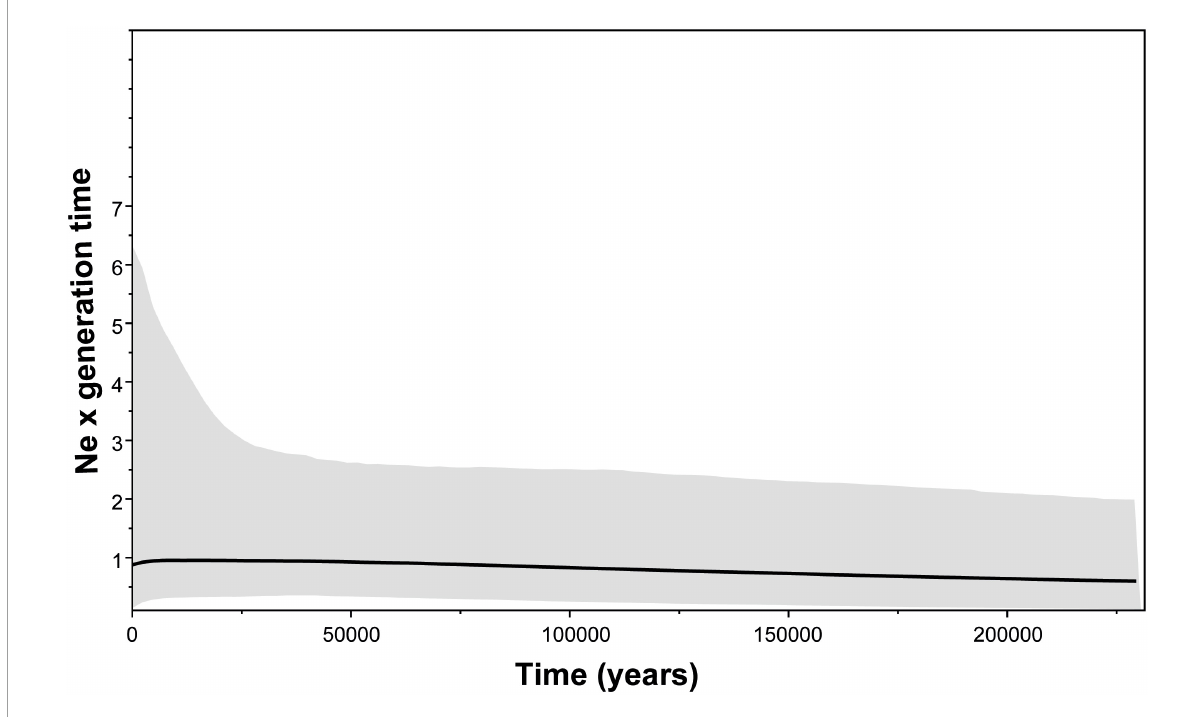
FIGURE8 Coalescent Bayesian Skyline Plot (BSP) used to infer demographic history of Plebeia flavocincta population. Black horizontal line shows median BSP estimate and gray area shows upper and lower 95% highest posterior density